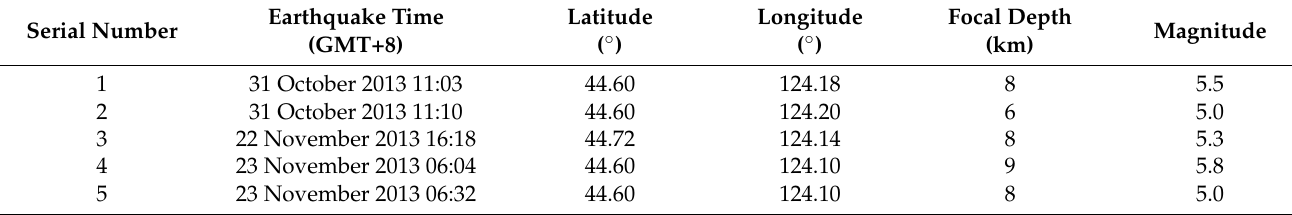
Table 3. Basic seismic parameters of Songyuan Ms. ≥ 5.0 earthquake swarm in 2013